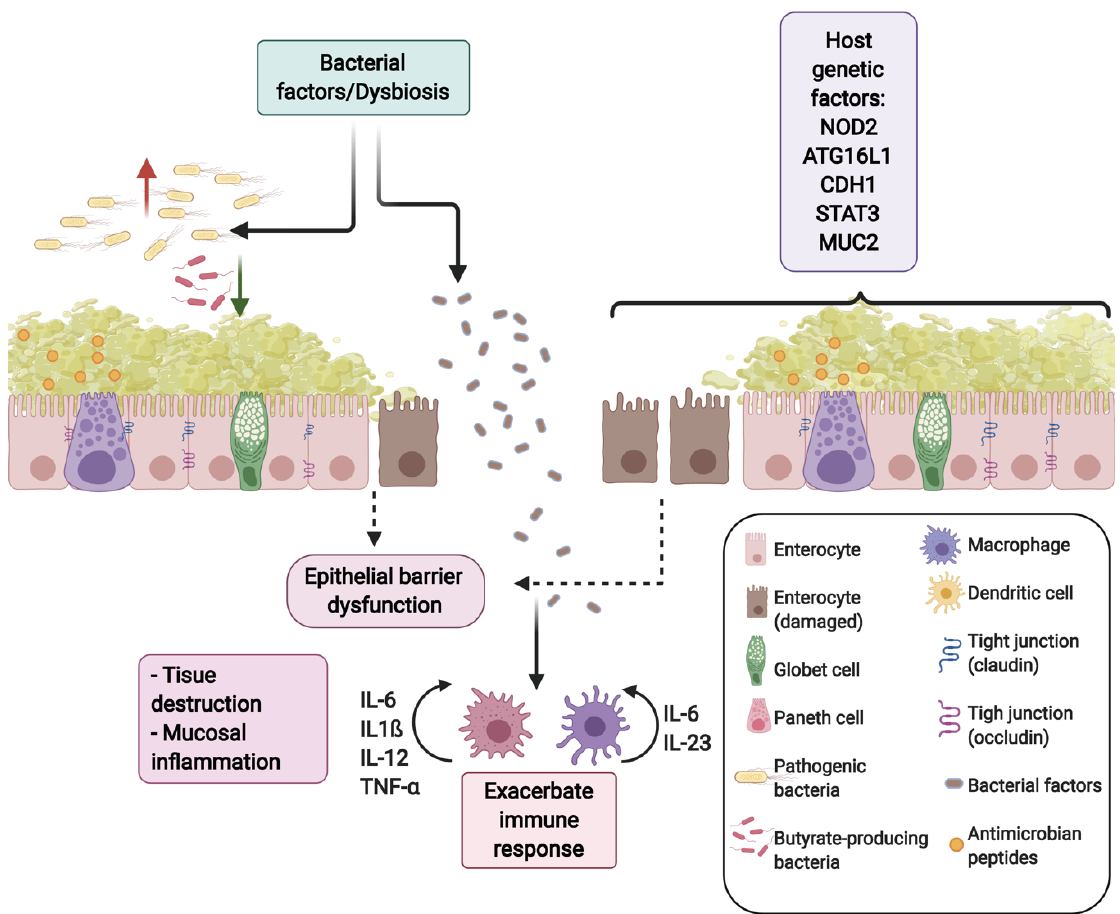
Figure 1. Genetic factors, alterations in the intestinal microbiota, and an exacerbated immune response cause a defect in the intestinal barrier function, affecting its integrity, increasing tissue destruction, and mucosal inflammation.